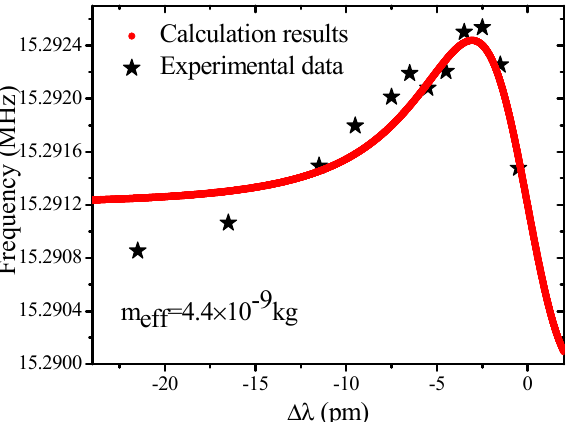
Figure 3. The optical spring effect (OSE) measured at 1 mW pumped power. Red lines are the simulated results with the effective mass of 4.4 × 10 − 9 kg and the experimental data. Δ λ = λ laser − λ cavity . The mechanical vibration frequency is significantly affected by the wall thickness of the